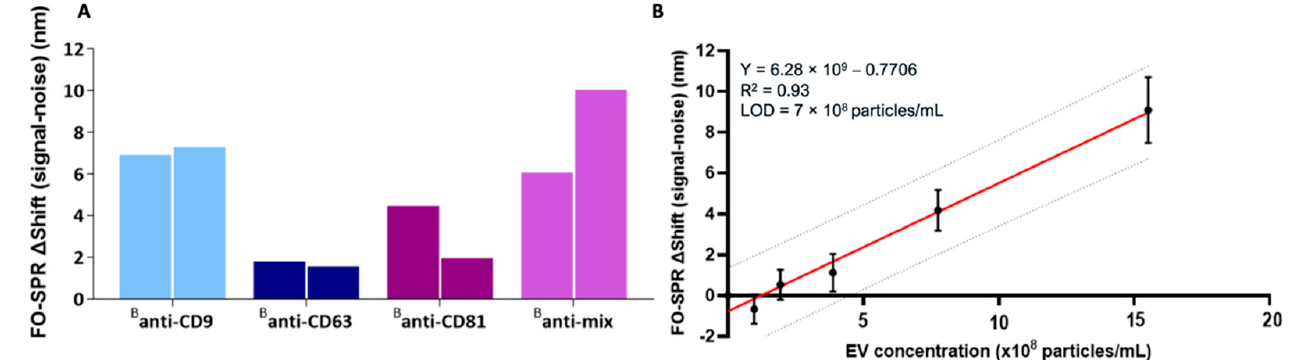
Figure 3. ( A ) FO-SPR sandwich bioassay with different antibody combinations for detecting SK-BR-3 EVs in 100-fold diluted pooled plasma. Bar graphs represent the FO-SPR shifts from two independent measurements (after subtracting the negative control, i.e., SPR signal for 0 particles/mL) obtained by combining anti-HER2 capture antibody with different detection antibodies ( B anti-CD9, B anti-CD63, B anti-CD81 or B anti-mix) for detecting SK-BR-3 EVs at 1.55 × 10 9 particles/mL concentration. ( B ) FO-SPR-based detection of a series of SK-BR-3 EV concentrations in 100-fold diluted pooled plasma when using anti-HER2/ B anti-CD9 antibody combination (obtained after subtracting the negative control, i.e., SPR signal for 0 particles/mL). Simple linear regression fitting was performed by GraphPad Prism software. The dotted lines indicate the 95% prediction bands for a new observation. Error bars represent one standard deviation ( n = 3).